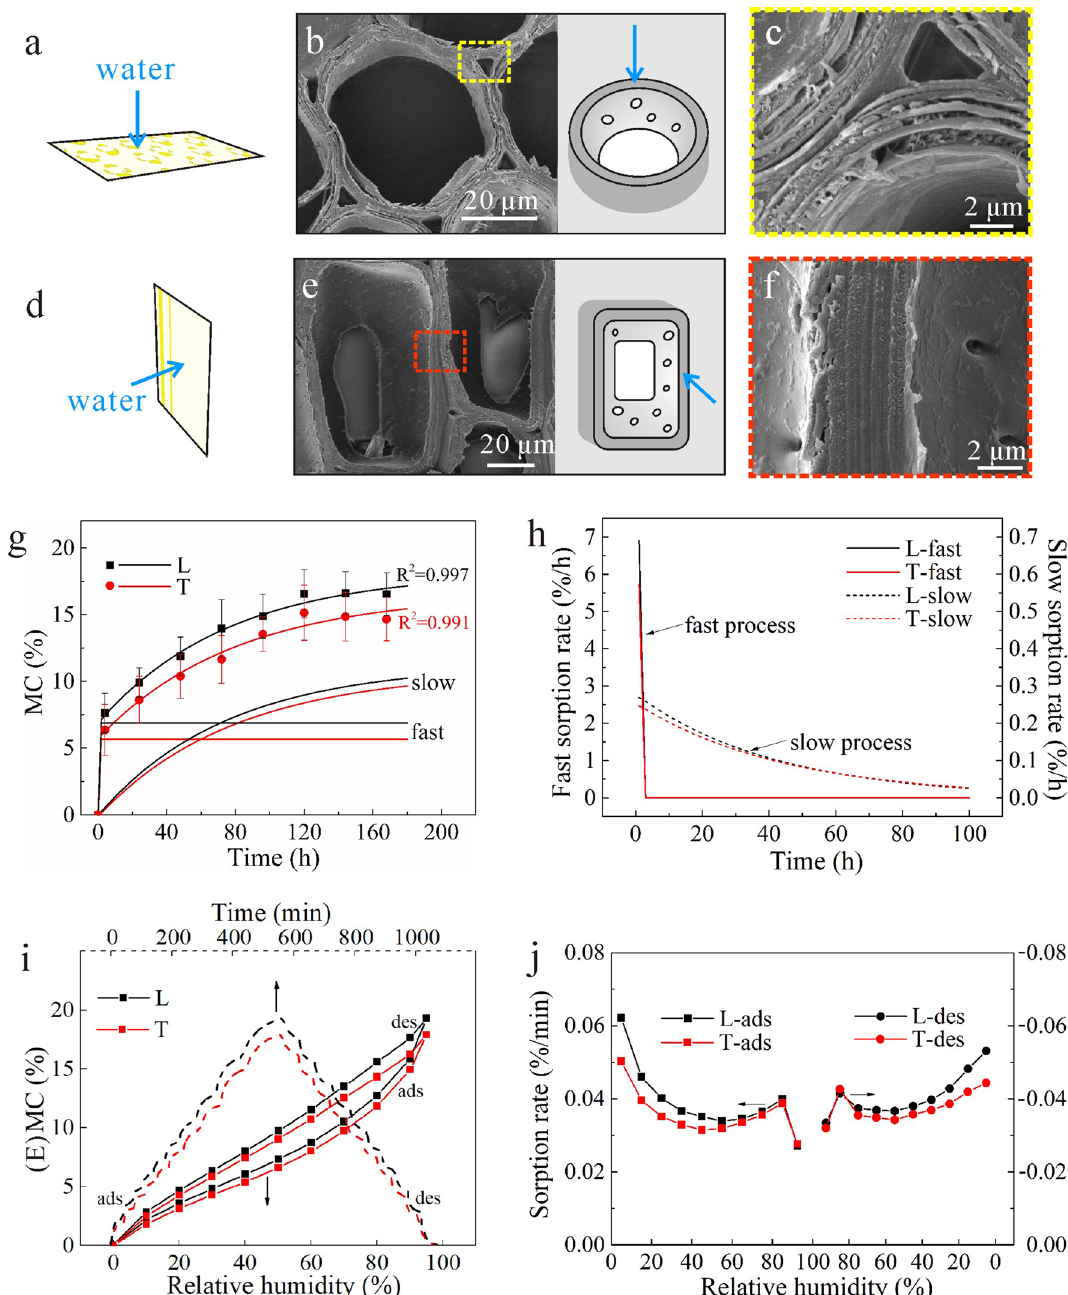
Figure 3. ( a – c ) Structural characterization of 30 μm specimen with longitudinal sorption direction: ( a ) graphical illustration of specimen, ( b ) SEM pictures of parenchyma cells, ( c ) SEM pictures of parenchyma cells walls. ( d – f ) Structural characterization of 30 μm specimen with transverse sorption direction: ( d ) graphical illustration of specimen, ( e ) SEM pictures of parenchyma cells, ( f ) SEM pictures of parenchyma cells walls. ( g – j ) Sorption behaviors of 30 μm specimens: ( g ) experimental data (dots) of MC over time by the saturated salt solution method, the PEK fitted curves (lines), and slow and fast processes of PEK model, ( h ) Sorption rates of fast and slow processes, ( i ) The DVS data of MC change during whole sorption process (MC change with time from 0 to 1200 min, and EMC change with RH from 0 to 95%), ( j ) sorptions rates during RH from 0 to